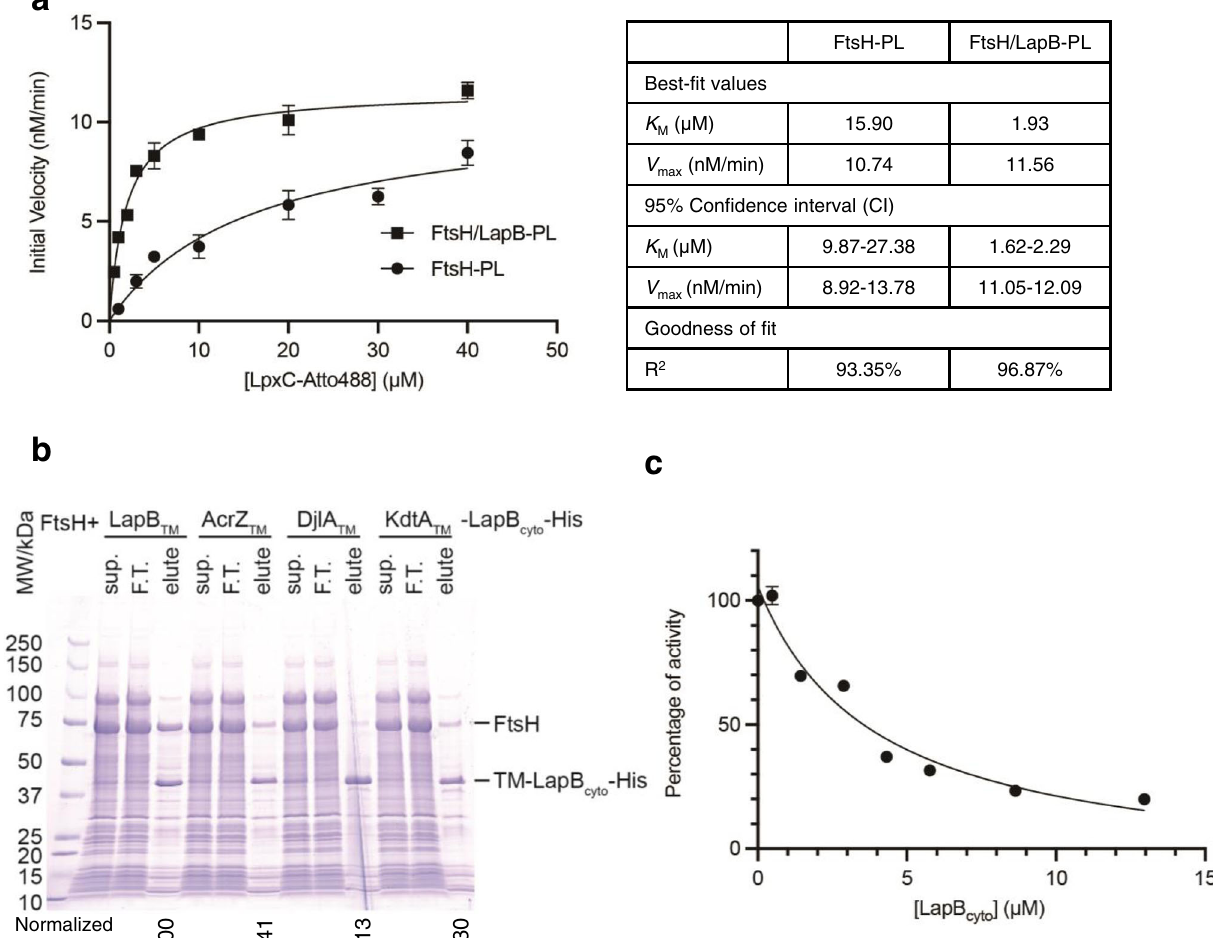
Fig. 1 | LapB is an adaptor speci fi c for FtsH-mediated LpxC degradation. a Kinetic analysis of LpxC degradation with proteoliposomes (PL). The initial rates of LpxC degraded by FtsH or FtsH/LapB proteoliposomes were fi tted to the Michaelis-Menten equation, and K M and V max were estimated. b Effect of replacing LapB ’ s TM helix. His-tagged wild-type or chimeric LapB proteins were expressed and af fi nity-puri fi ed from bacteria, and co-elution of FtsH was examined. The normalized ratio of SDS-PAGE intensities of co-eluted FtsH and LapB bands are listed below the lane of elution. Sup., supernatant of detergent-solubilized